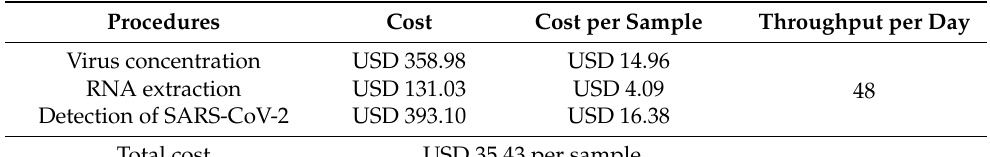
Table 3. Cost analysis for the detection of SARS-CoV-2 in hospital wastewater using an RT-qPCR assay.